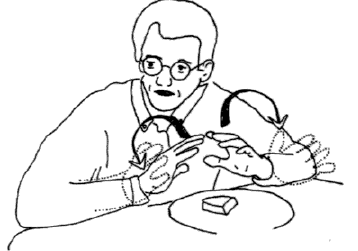
Figure 2: Gesture depicting “greasy”, example (11) (Kendon